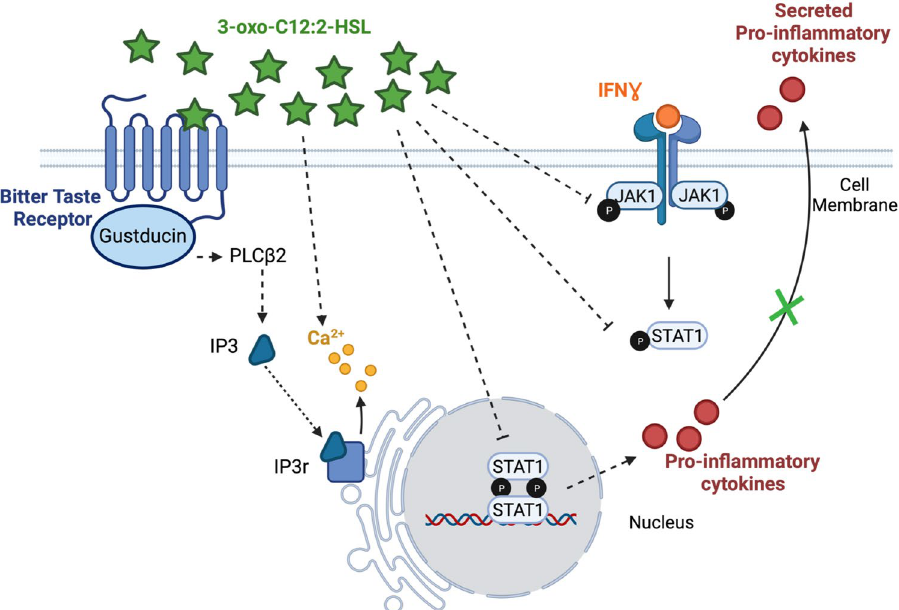
Figure 5. Proposed mechanisms of 3-oxo-C12:2-HSL effects on inflammation. In immune cells, 3-oxo-C12:2- HSL is able to activate bitter taste receptors, which are G-protein coupled receptors, triggering a signalling cascade resulting in the release of calcium from the endoplasmic reticulum. In addition, in murine activated macrophages the presence of 3-oxo-C12:2-HSL attenuates the activation of the JAK-STAT signalling pathways, by specifically preventing JAK1 and STAT1 phosphorylation. This leads to a decrease in pro-inflammatory cytokine secretions and an overall reduced inflammatory response. Part of the effects of 3-oxo-C12:2-HSL on inflammatory response is dependent on bitter taste receptors. Created with